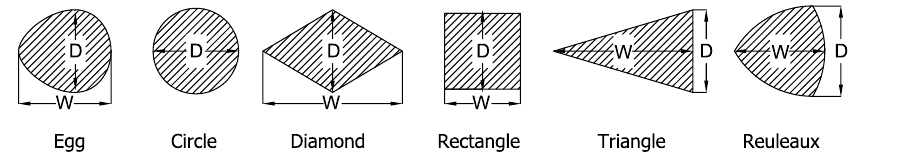
Figure 2. Geometry of the bluff bodies. Dimensions are given in Table 1.